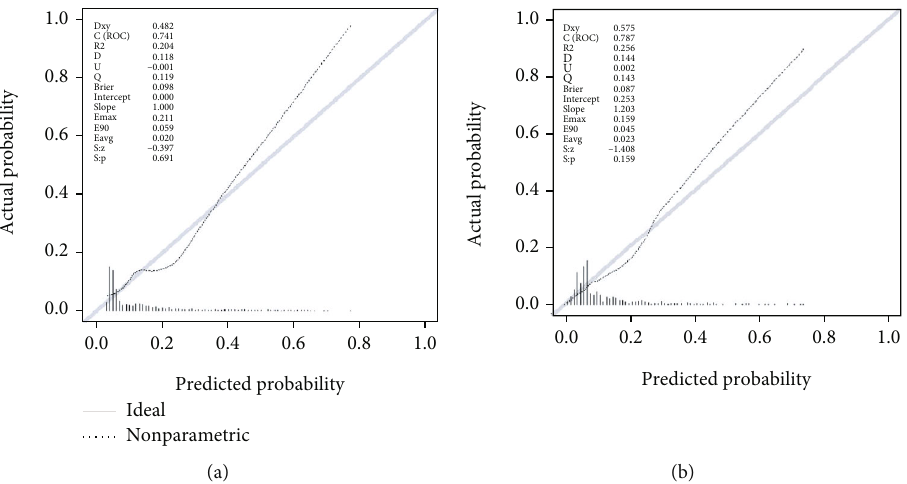
Figure 5: Calibration curve of the diabetic foot ulcer risk prediction model. (a) Calibration curve of the diabetic foot ulcer risk prediction model in the primary cohort. (b) Calibration curve of the diabetic foot ulcer risk prediction model in the validation cohort. The gray solid line “ Ideal ” at the zero-crossing point represents the ideal curve, and the black-dotted line “ Nonparametric ” represents the actual prediction accuracy of the model. The closer Nonparametric is to Ideal, the better the prediction accuracy of the